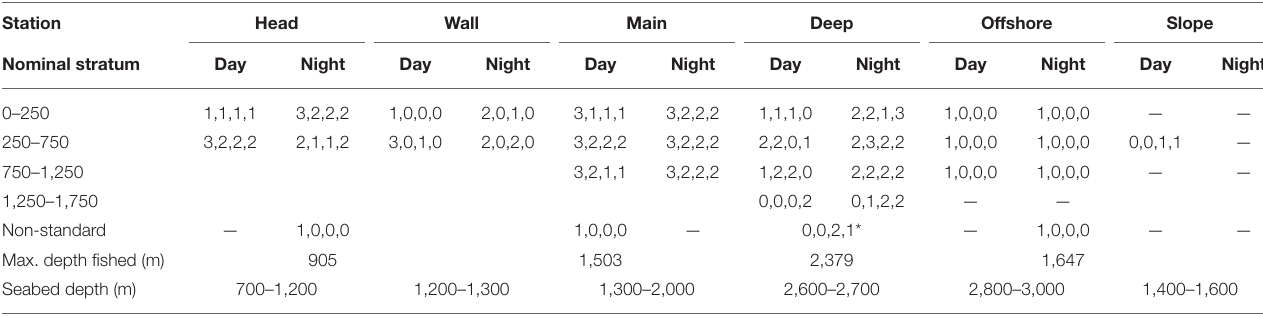
TABLE 1 | Number of IYGPT sets in each cell of the survey design that were utilized in the multivariate analyses (numbers of sets made in each of the 2007, 2008, 2009, and 2010 surveys shown in sequence). Station Head Wall Main Deep Slope Nominal